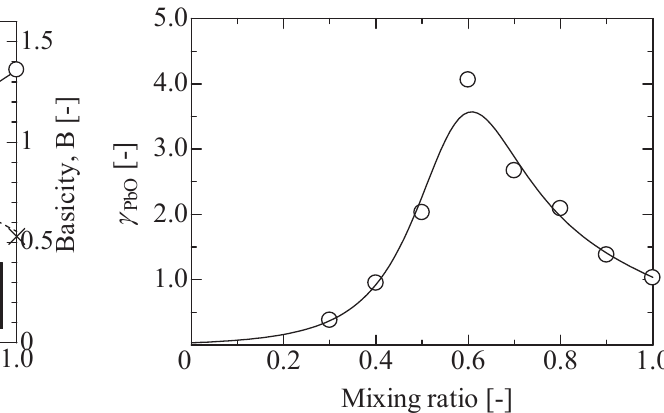
Figure 6. Changes in the FeO content and basicity with the mixing ratio of the slag; the mixing ratio is the ratio of the amount of nonferrous smelting slag to the total amount of slag.